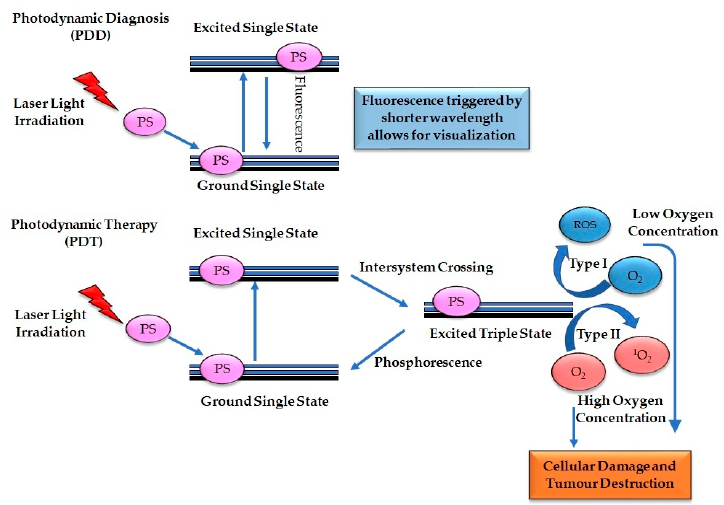
Figure 1. Principle of Photodynamic diagnosis and photodynamic therapy. Photoexcitation of a photosensitizer which stimulates fluorescence emission for cancer detection and a long-lived triplet state, which can trigger Type I or Type II cytotoxic oxygen species resulting in cell